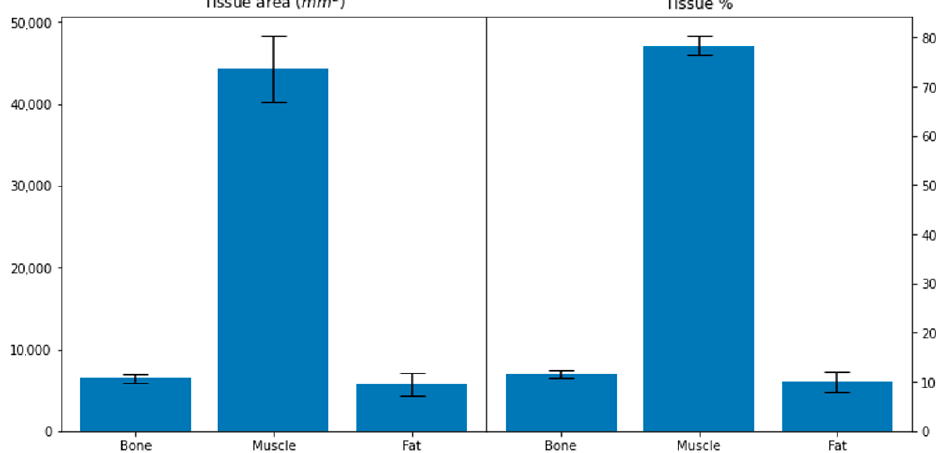
Figure 6. Area and percentage composition of tissue types within predicted ovine medical images. Using the threshold windows for each of the respective tissue types, the total area occupied was calculated for each tissue type ( left ) and what percentage this represented within each individual CT scan ( right ). On average, the area of bone, muscle and fat across the dataset was 6488 ± 533, 44,274 ± 4051, 5712 ± 1377. Carcass tissue composition percentage-wise for bone, muscle and fat was 11.52 ± 0.78, 78.41 ± 1.90 and 10.07 ± 2.03 %.